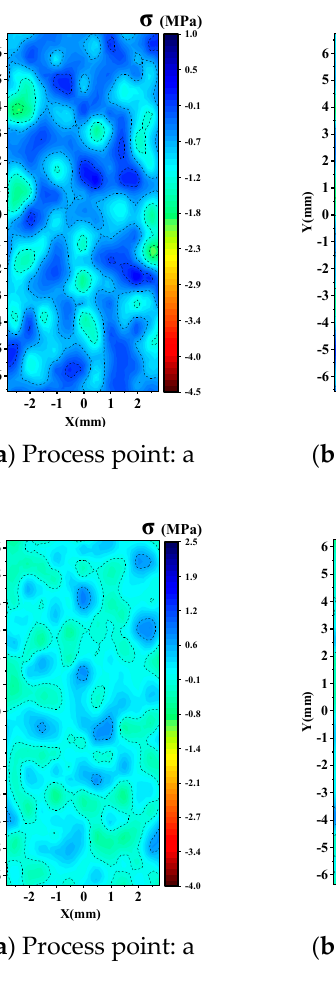
Figure 16. The normal stress evolution of the 3D nonpersistent joint during loading. Figure 17 shows the evolution of the shear stress on the 3D nonpersistent joint surface under uniaxial loading. For the specimens with θ = 0 ◦ and 90 ◦ , the variation in the stress concentration area is very slight (Figure 17a,d), which is attributed to the lack of slip behaviour along the joint surface during the fracture process of the specimens. Unlike the specimen with θ = 0 ◦ and 90 ◦ , the variation in the stress concentration area at 75 ◦ is the most significant, followed by that at 30 ◦ . Regardless of the slip fracture mode or mixed fracture mode, slip will occur along the joint plane during specimen failure, so all rock bridges on the joint plane will not always play a supporting role in the entire loading process. Thus, after the failure of the specimen, the joint plane is staggered due to the slip, so the support area changes and the shear stress distribution area also changes accordingly (Figure